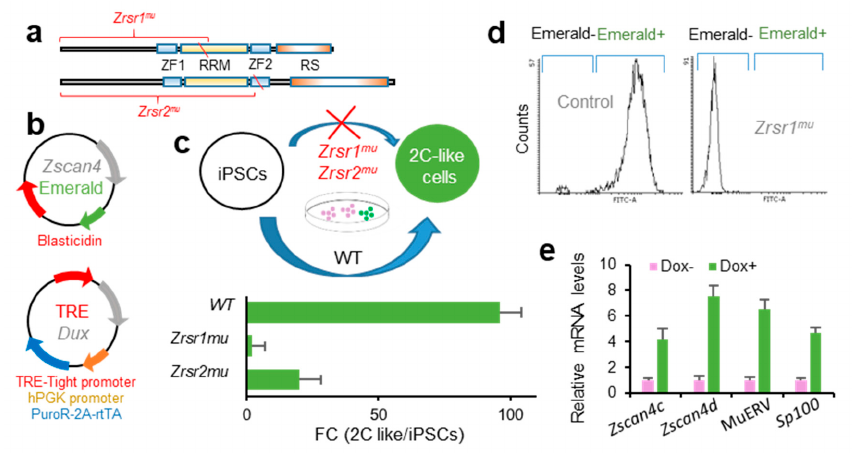
Figure 3. Zrsr1 mu and Zrsr2 mu block activation of the 2-cell transcription program induced by Dux expression and impair conversion of induced pluripotent stem cells (iPSC) to a 2 cell-like cells (2CLC) state. ( a ) Diagram of Zrsr1 and Zrsr2 mutants with their functional domains: ZF: Zinc Finger, RRM: RNA recognition motif, RS: arginine-serine rich. Diagonal red line indicates the position of the mutation. ( b ) Diagram of the plasmid-expressing Emerald under Zscan4 promoter [37] and of a doxycycline-inducible lentiviral construct [27]; both plasmids were stably integrated into iPSC. ( c , d ) Diagram of iPSC metastability (top) and enrichment in 2CLCs relative to conventional iPSCs (bottom) produced after Dux expression in control iPSCs but blocked when Zrsr1 or Zrsr2 are mutated ( c ), as confirmed by flow cytometry ( d ) using two cell cultures per condition. ( e ) Relative mRNA expression in WT Dux-induced iPSCs (2CLCs) of genes related to 2-cell embryo genome